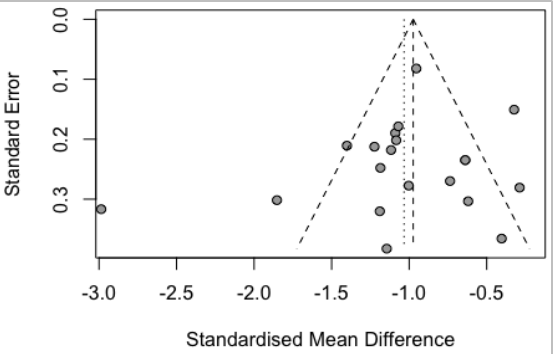
Figure A6. There are a few studies outside the confidence bounds for a fixed effect model including one outlier, but the studies are still well balanced on either side of the effect estimates. So, the funnel plot does not reveal an obvious presence of publication or other bias for stable MCI versus MCI_AD.